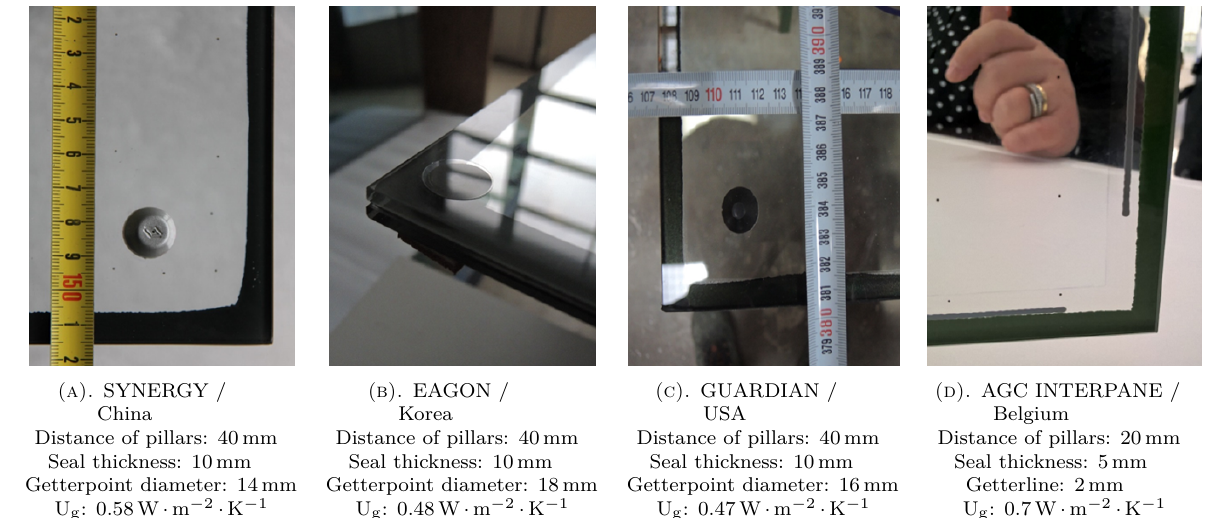
Figure 1. From left to right: Different vacuum glazing products (partly [2–5], partly own illustrations).